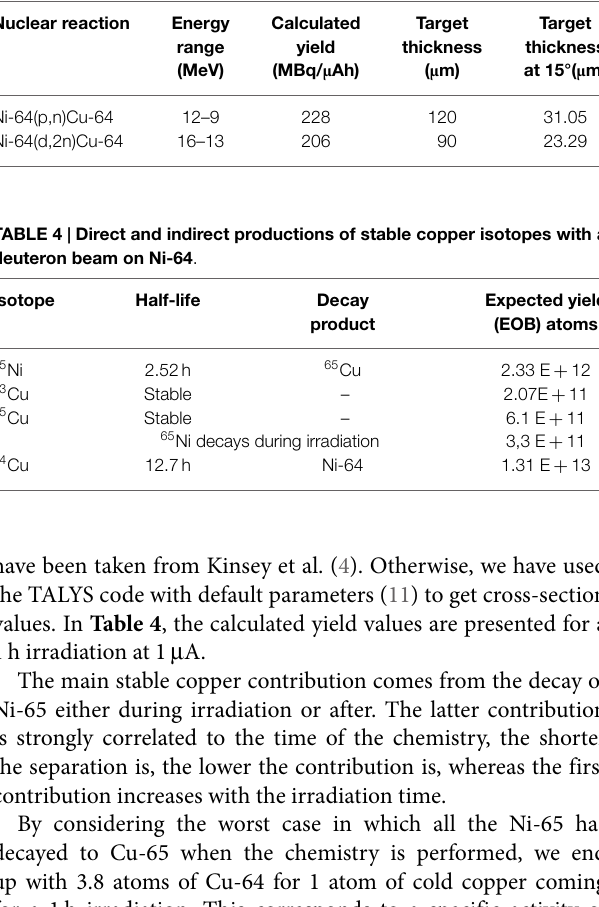
is lower than 1 ppm. These numbers show that deuterons can TABLE 3 | Cu-64 calculated yields for (p,n) and (d,2n) production routes .